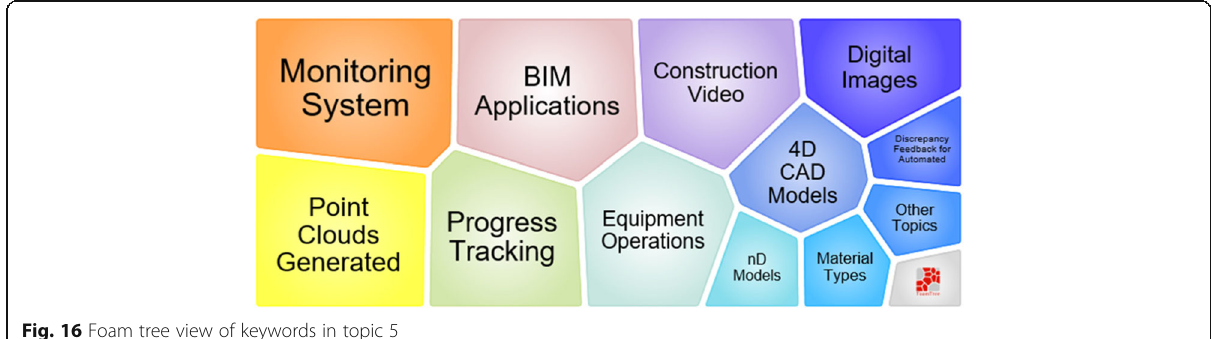
Fig. 16 Foam tree view of keywords in topic 5